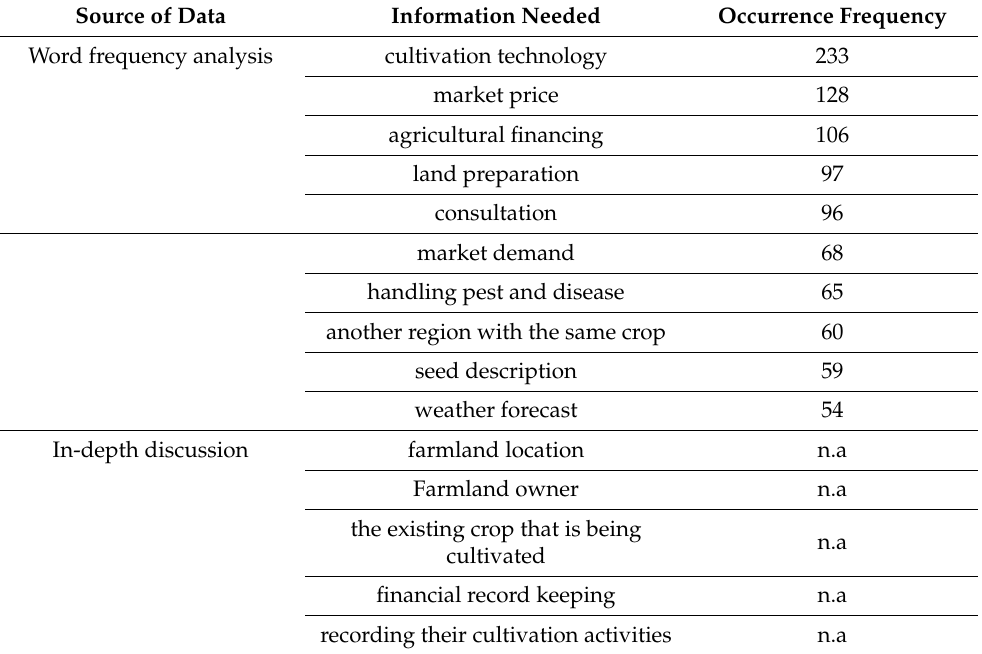
Table 3. The smallholder farmers’ information needs in Sukabumi and Bandung Barat